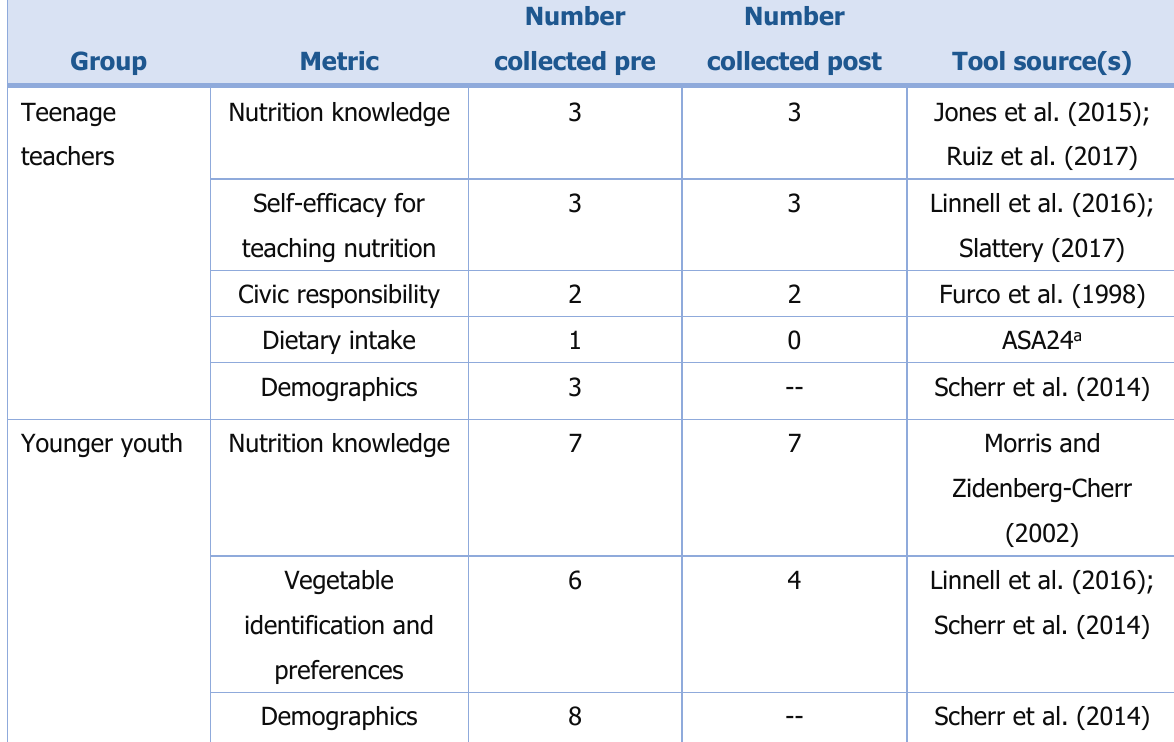
Table 1. Evaluation Tools and Metrics Collected from Participants During the 1 st Implementation